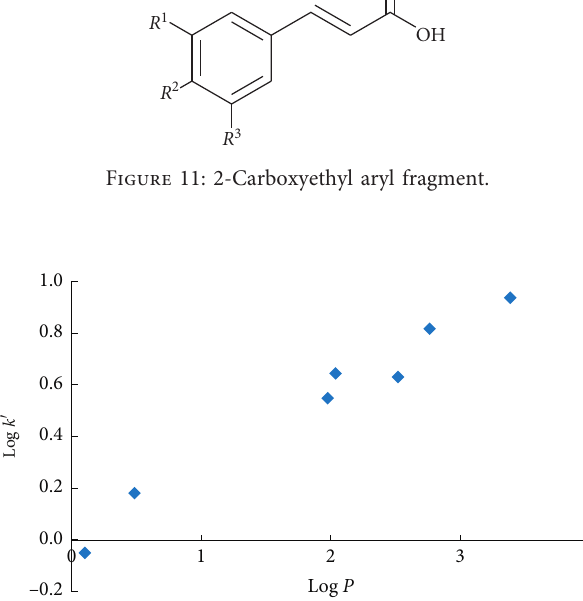
Figure 12: Relationship between the retention factors of nitrogen- containing compounds on SP-2 and their hydrophobicity